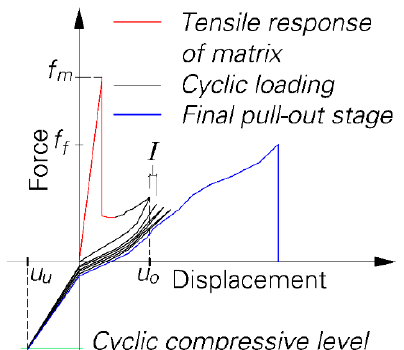
Figure 2. Progression of the force-displacement curve during different loading stages. Table 3. Loading parameters for the testing series under investigation.